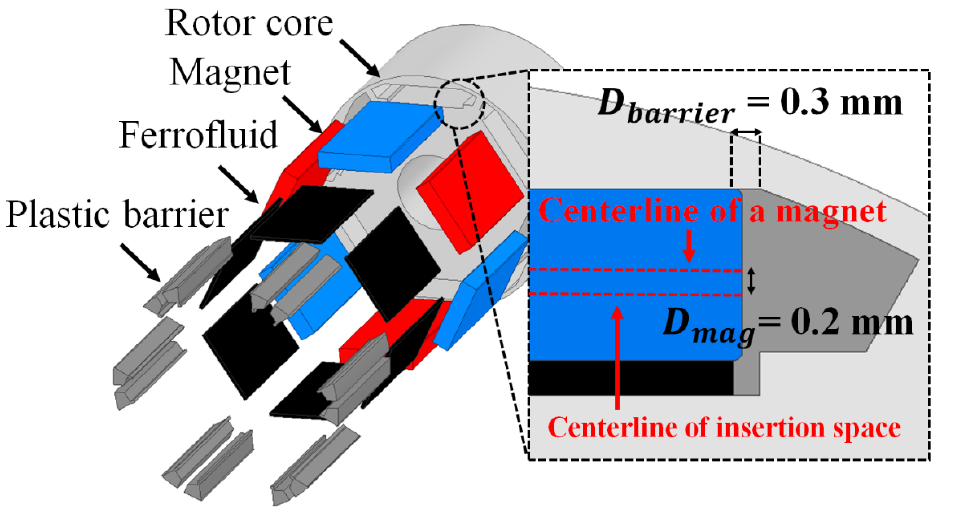
Figure 10. No-load back EMF variation with D mag (4000 rpm).